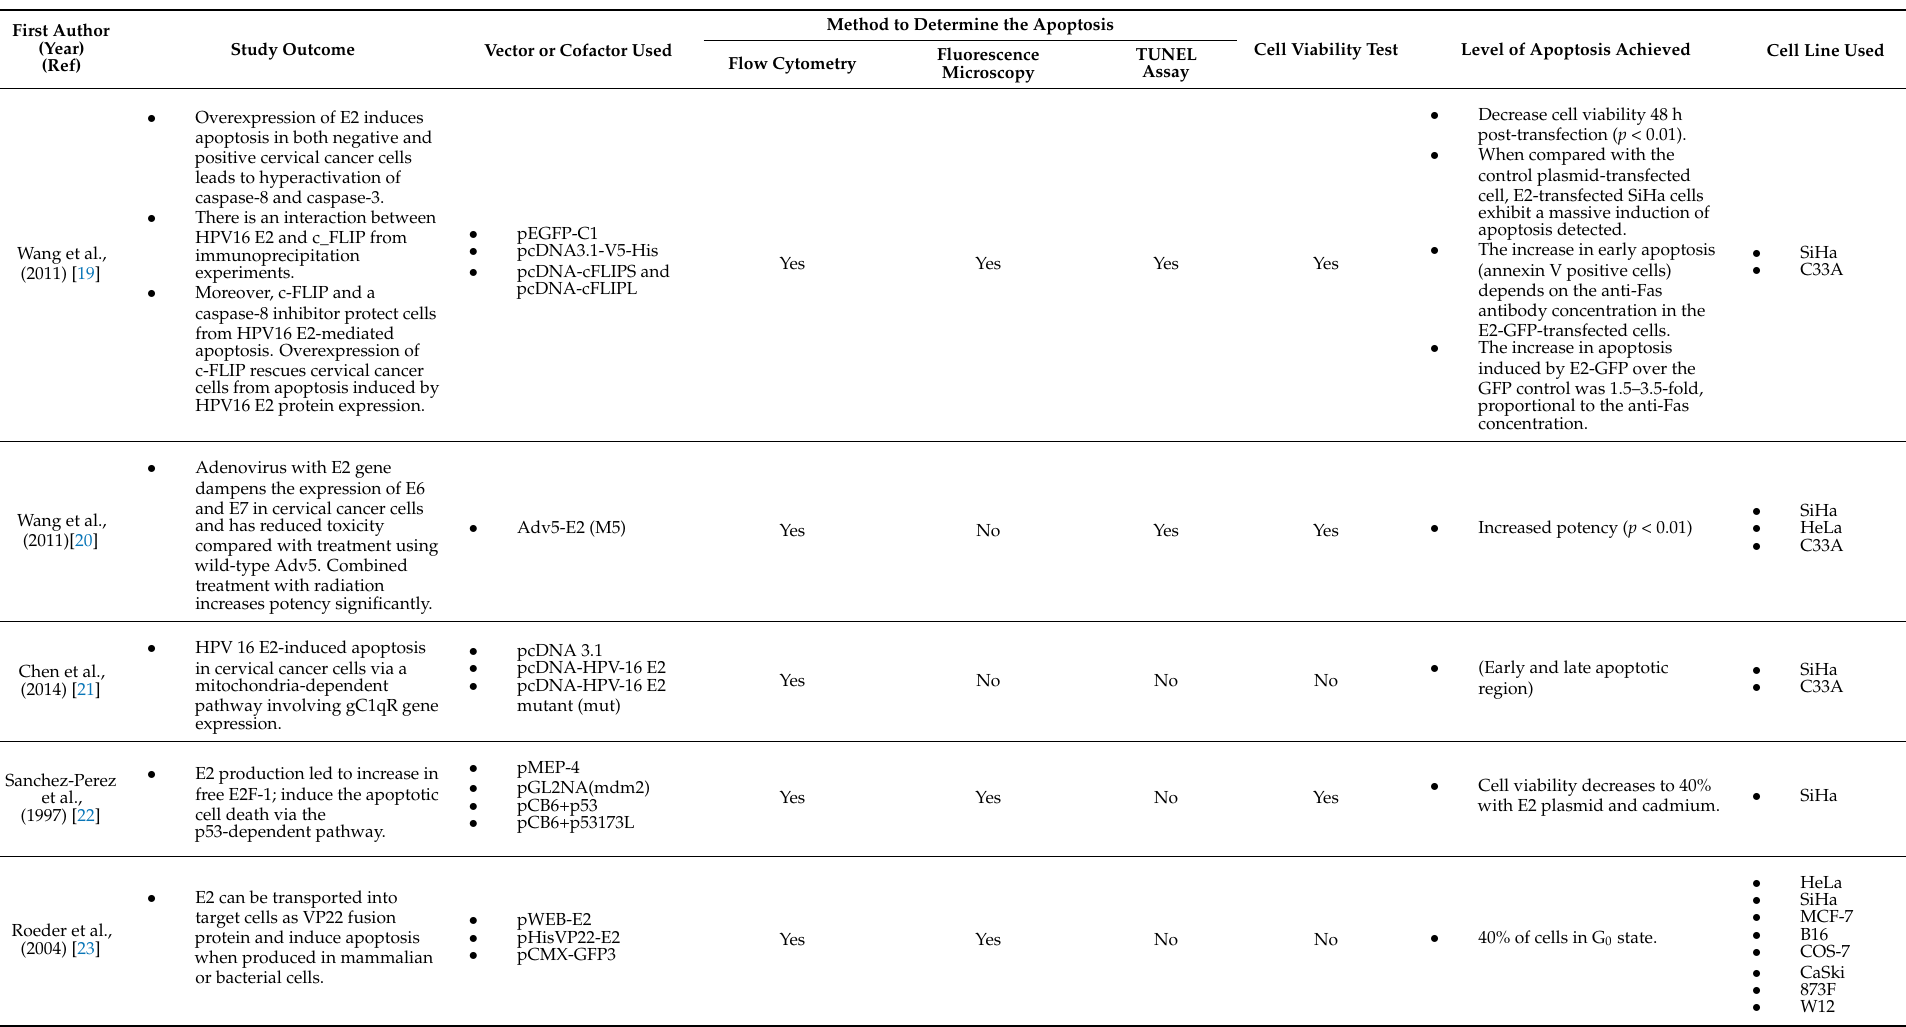
Table 1. Information summary of study outcome, type of cell line, plasmid construct, methods to measure apoptosis, and level of